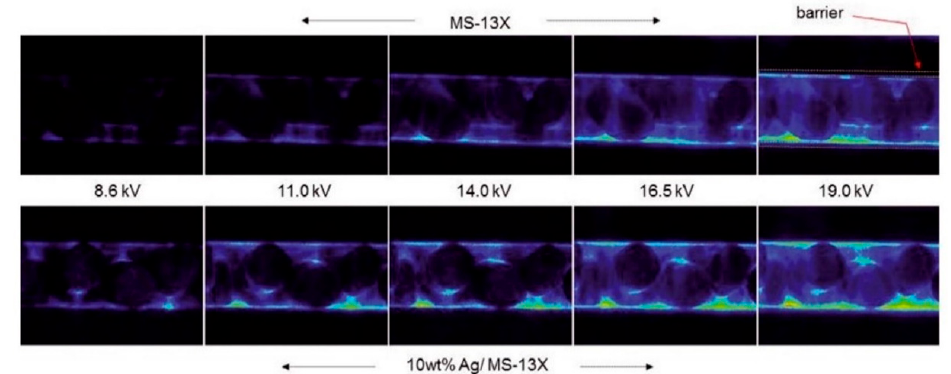
Figure 15. ICCD camera snapshots of the discharge plasma over molecular sieve 13X zeolite (MS-13X) with or without Ag loading; (frequency = 50 Hz, 2× lens, 2 mm gap, exposure time = 100 ms). Reprinted from Reference [32], © EDP sciences, 2011.